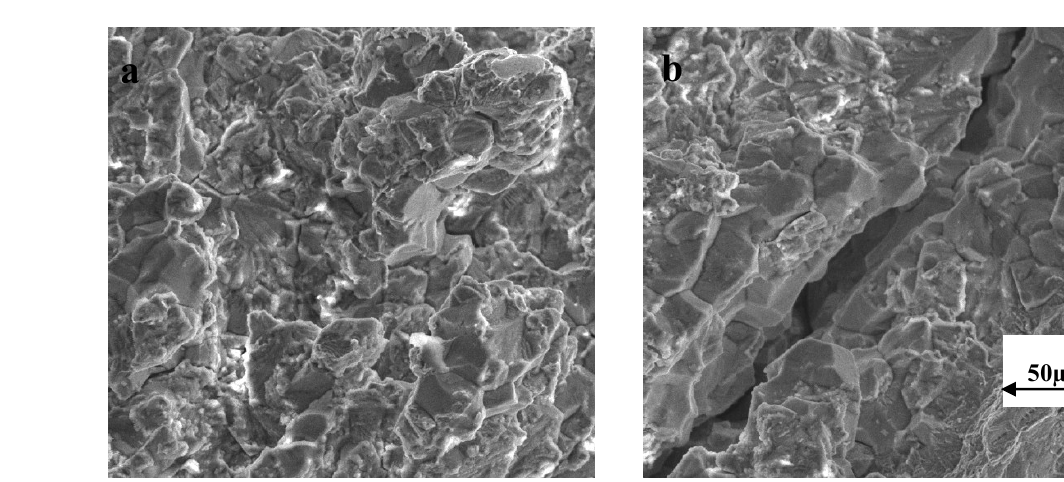
Figure 3. SEM fractograph of 316L tested in 30 wt. % MgCl 2 at 150 °C, showing intergranularstress corrosion cracking (SCC) that covered a considerable fraction of the fracture surface, when tested at strain rates: ( a ) 3.7 × 10 −7 s −1 and ( b ) 5.3 × 10 −7 s −1